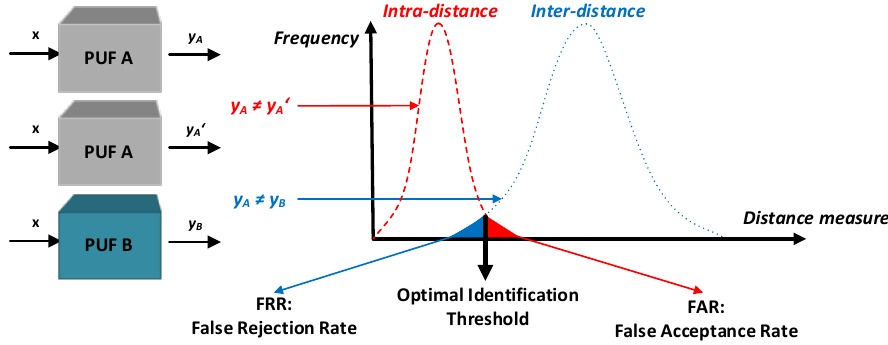
Figure 1. Intra-distance and inter-distance histogram